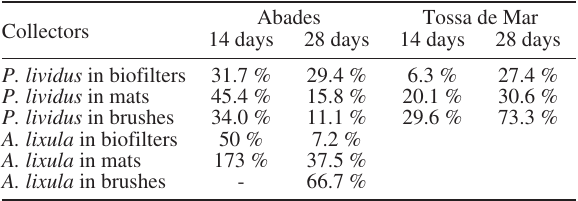
Table 5. – Coefficients of variation for the number of P. lividus and A. lixula settlers collected by each type of artificial collector at each site (Abades and Tossa de